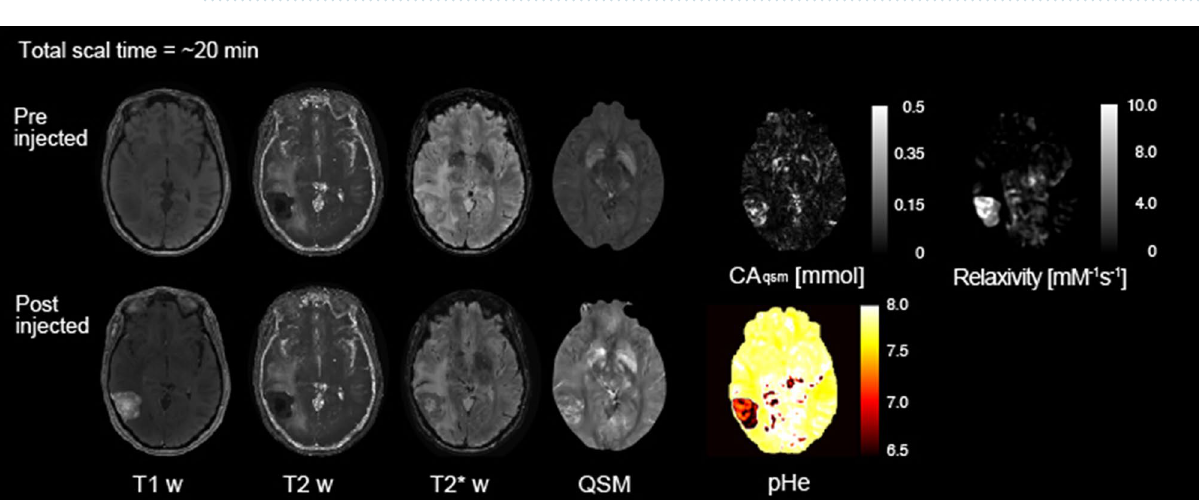
Figure 6. Contrast-enhanced synthetic T1w image-derived QPM and pHe maps. The synthetic T1w and pHe maps indicate contrast-enhanced lesions and pHe changes with a color scale bar [pH 6.5–8.0].